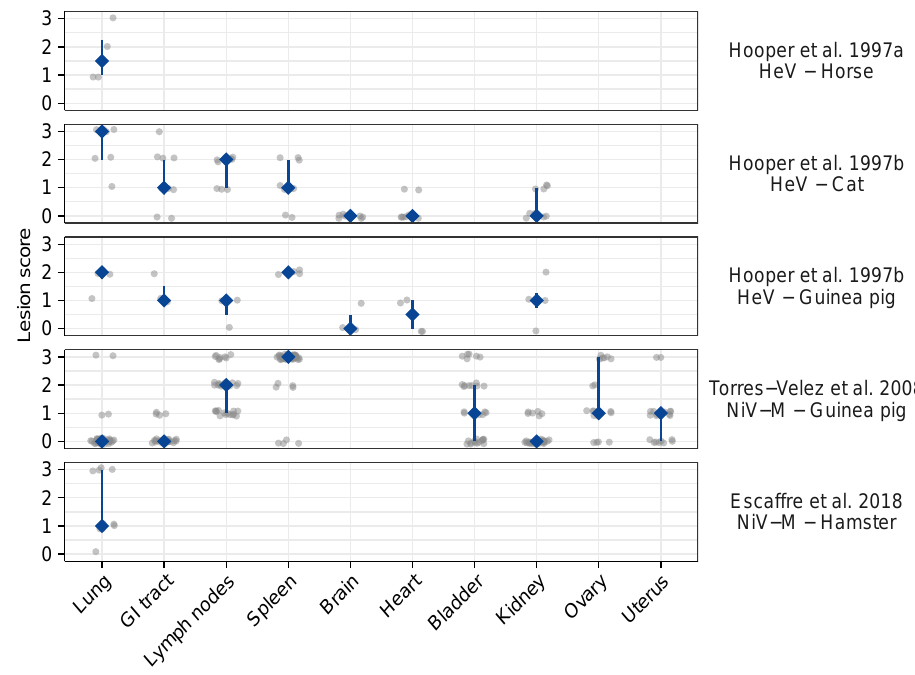
Figure 5. Scoring of histological lesions (including but not restricted to syncytia) following experi- mental henipavirus infection in vivo. Grey dots represent individual data points (horizontally jittered to avoid overplotting); dark blue diamonds and vertical bars represent the corresponding median and interquartile ranges; blank spaces indicate that no data are available. GI tract: gastro-intestinal tract. Individuals received different doses and samples were collected from 2 to 17 days post-infection. Lesion scores were based on observations of hematoxylin-and-eosin stained slides, and attributed as following. Hooper et al. 1997a [110]: presence of syncytia was noted on a comparative scale from 0 to 3. Hooper et al. 1997b [108]: presence of lesions was on a comparative scale from 0 to 3; lesions were syncytial cells, particularly but not exclusively in vascular endothelium, edema, cellular infiltration, and necrosis. Torres-Velez et al. 2008 [45]: 0, no abnormal findings; 1, minimal changes consisting of focal inflammation with some necrosis and rare syncytial cells; 2, moderate changes consisting of necrosis that can be focally extensive with or without inflammation, syncytial cells are usually prominent; 3, severe inflammation, extensive necrosis, hemorrhage, and numerous syncytial cells. Escaffre et al. 2018 [95]: 0, no detectable syncytia; 1, rare (1–2 syncytia/section); 2, occasional (3–5 syncytia/section); 3, frequent (5 or more